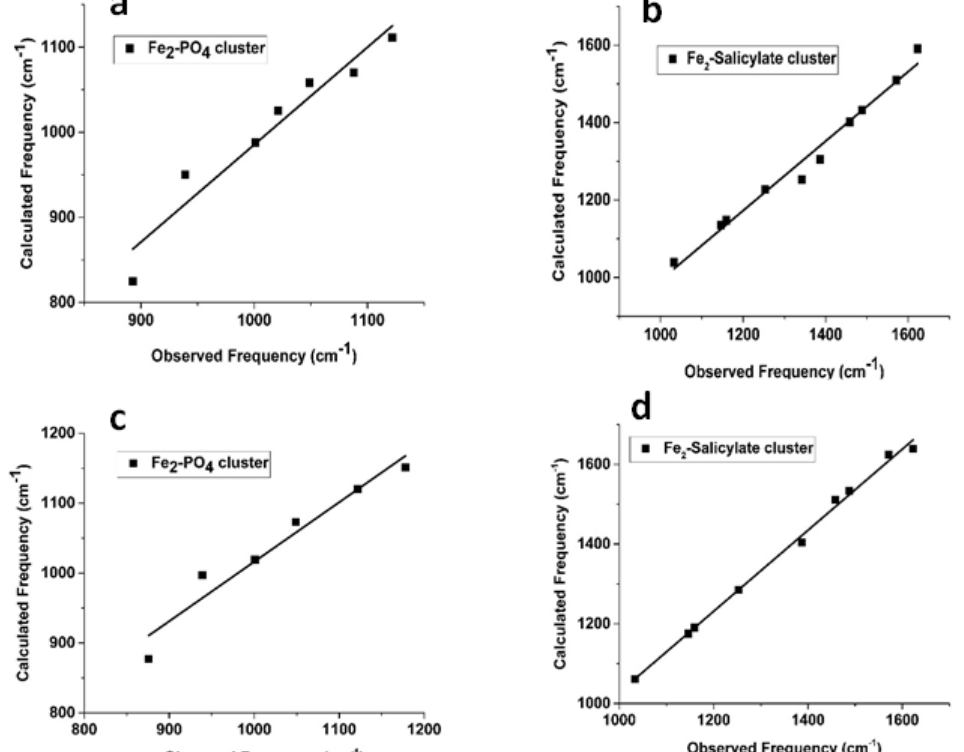
Figure 4 . Linear correlations of calculated versus observed frequencies for phosphate and salicylate complexes in (210) monodentate ( a , b ) and (101) bidentate bridging ( c , d ) configurations in clusters of Fe 2 (OH) 4 (OH 2 ) 52+ and Fe 2 (OH) 4 (OH 2 ) 42+ . ( a ) Slope = 1.14, Intercept = − 160, R 2 = 0.93, ( b ) Slope = 0.90, Intercept = 96, R 2 = 0.98, ( c ) Slope = 0.85, Intercept = 166, R 2 = 0.94, ( d ) Slope = 1.02, Intercept = 11, R 2 =